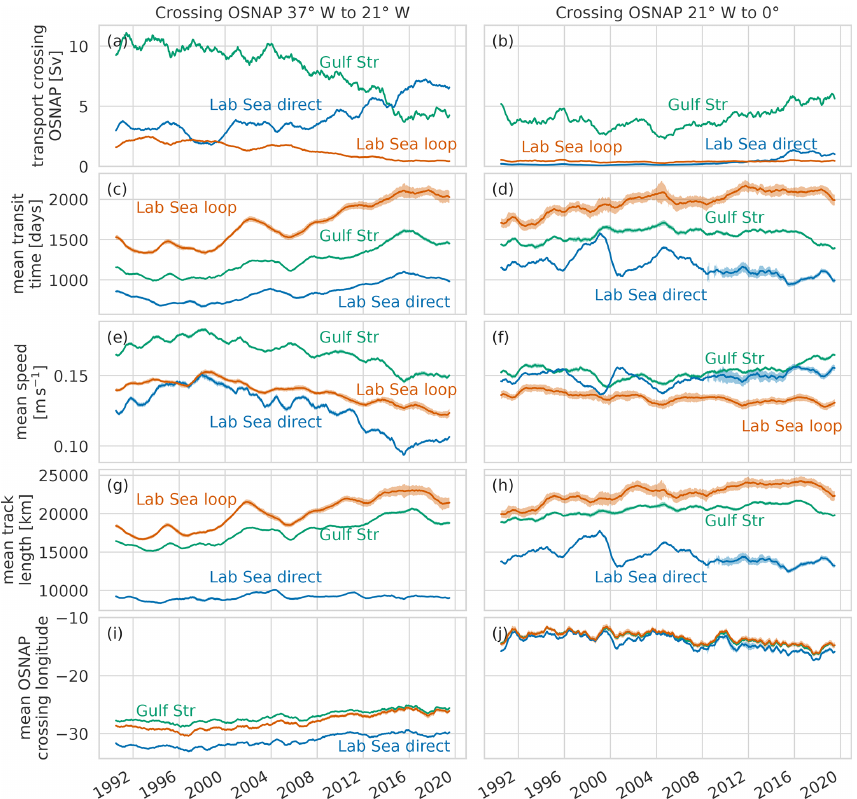
Figure 8. Evolution over time of particle transit times. Time series of mean volume transports (a, b) , transit times (c, d) , speeds (e, f) , track lengths (g, h) , and OSNAP E − 37W − 500m crossing longitudes (i, j) of particles by source region. Results are divided into OSNAP E − 37W − 500m crossings west (left column) and east (right column) of 21 ◦ W, the western flank of the Rockall–Hatton Bank. Times on the x axis are crossing times of OSNAP E − 37W − 500m , so values represent weighted averages of conditions along-track in the preceding years. Time series are smoothed with a 1-year rolling